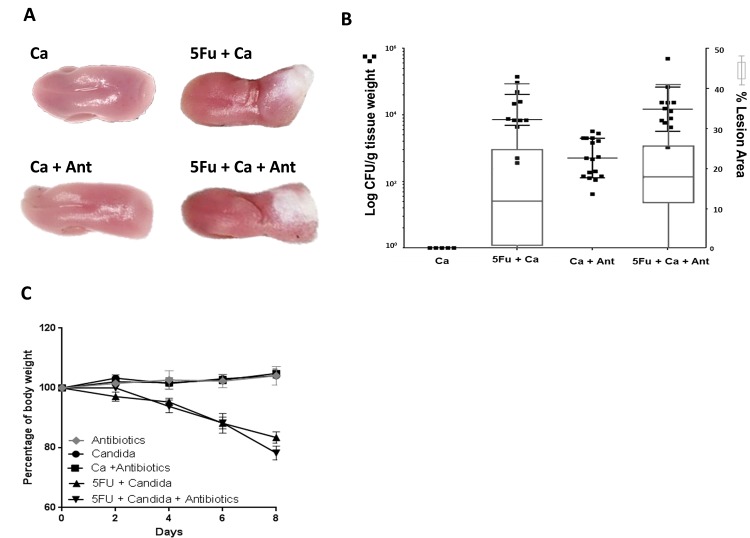
Effect of antibiotic treatment on oral fungal burdens and biofilm surface area in 5Fu-treated mice.Antibiotics were started three days prior to 5Fu-treatment and continued for 8 days. A: Excised tongues after 8 days of C. albicans SC5314 inoculation. Groups receiving 5Fu with C. albicans SC5314 (5Fu+Ca) had thick mucosal biofilms covering the posterior tongue surface regardless of antibiotics (Ant) treatment. No biofilms formed in C. albicans-inoculated healthy mice with (Ca+Ant) or without (Ca) antibiotic treatment. B: Relationship between C. albicans burdens and biofilm surface area. Figure depicts log fungal CFUs/gm of tissue (dot plot, left Y axis) and corresponding biofilm lesion area (box and whiskers plot, right Y axis) in tongues of four groups of mice (day 8). Mice received C. albicans SC5314 in the drinking water alone (Ca), 5Fu with C. albicans (5Fu+Ca), C. albicans with antibiotics (Ca+Ant) or combination of the three (5Fu+Ca+Ant). Tissues were homogenized, serially diluted and plated for CFU counts. Biofilms were digitally photographed, images were analyzed by Image J and results were expressed as the percentage of dorsal tongue area covered by visible biofilm (white area). In groups treated with 5Fu there were no differences in fungal burdens (p = 0.53) or biofilm area (p = 0.25) between mice receiving antibiotics or not. In mice not receiving 5Fu, antibiotic treatment led to increased C. albicans burdens (p<0.005) but there was no biofilm lesion on the tongue surface indicating that in healthy mice increased fungal burdens are not sufficient for virulence. Data are from 2 independent mouse experiments, with 5–8 mice per group; bars represent means ± SEM. C: Body weight loss in each group during the eight-day infection period, expressed as percentage of initial weight (day 0) in 5–10 animals per group from 2 independent experiments. Error bars represent SEM. Candida-Infected mice receiving 5Fu with or without antibiotics lost 20% of total body weight by day 8.